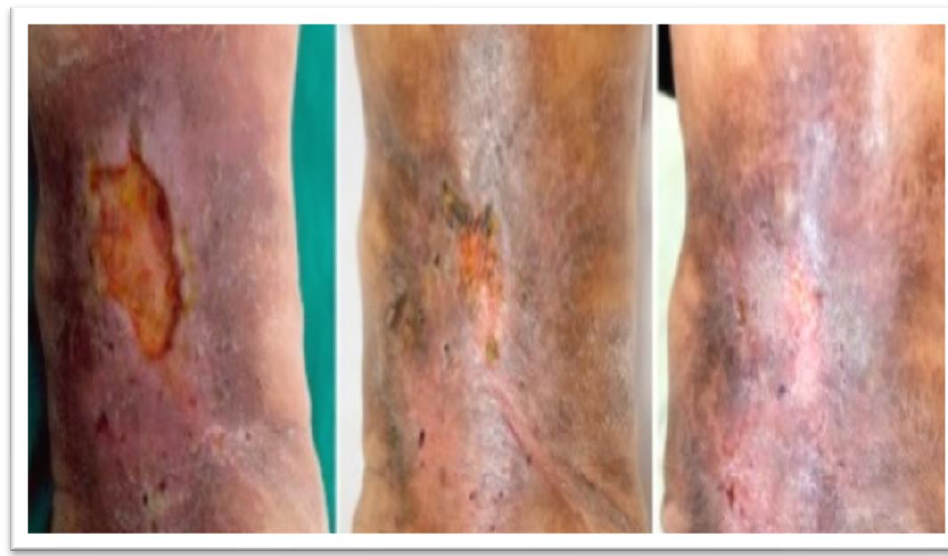
Figure 2. Example of wound healed completely (left, week 0; middle, week 7; right, week 12).